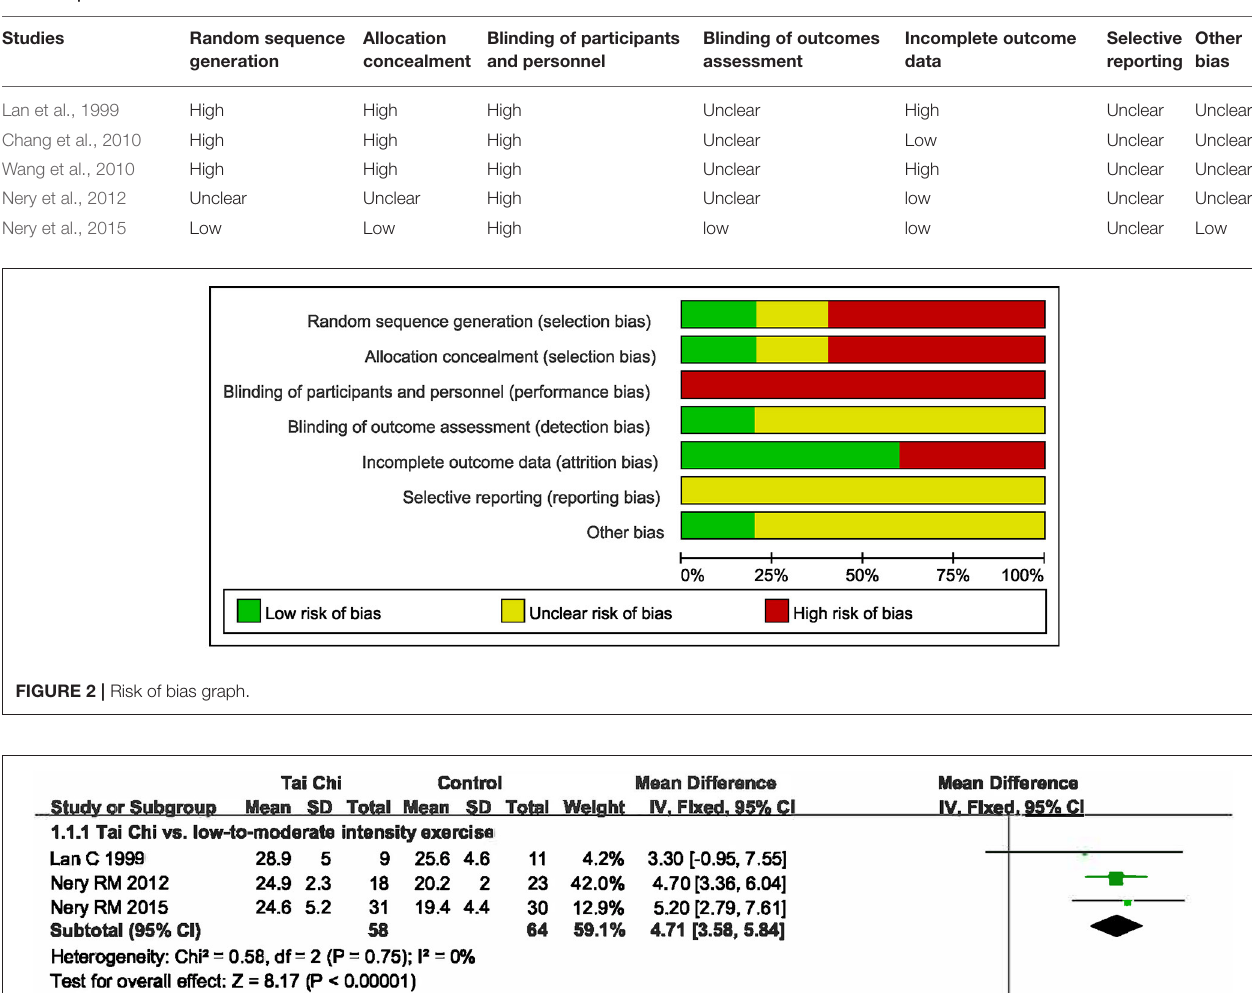
TABLE 2 | Risk of bias assessment.